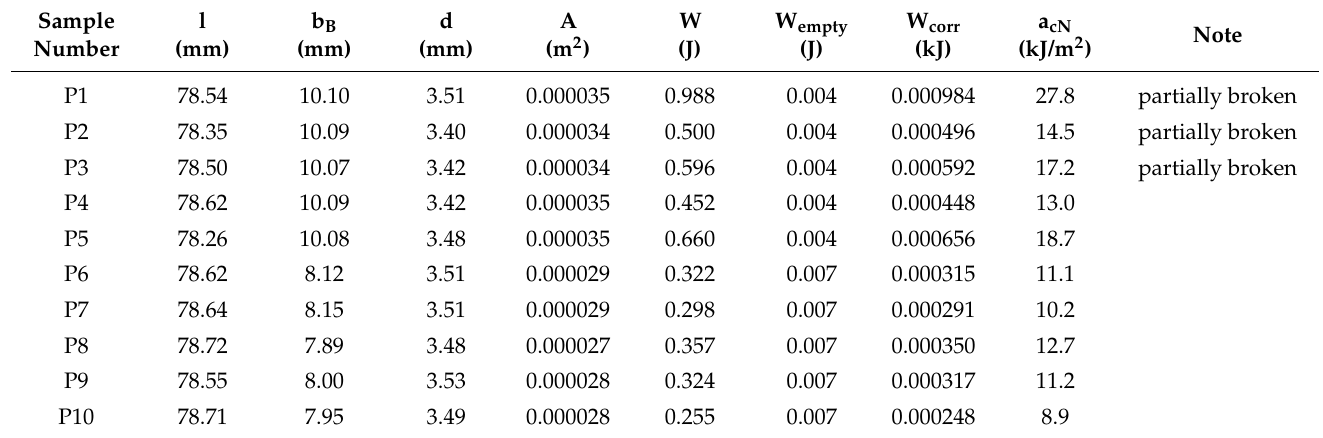
Table A6. Results of the notched impact tests and unnotched impact tests of P_PE.